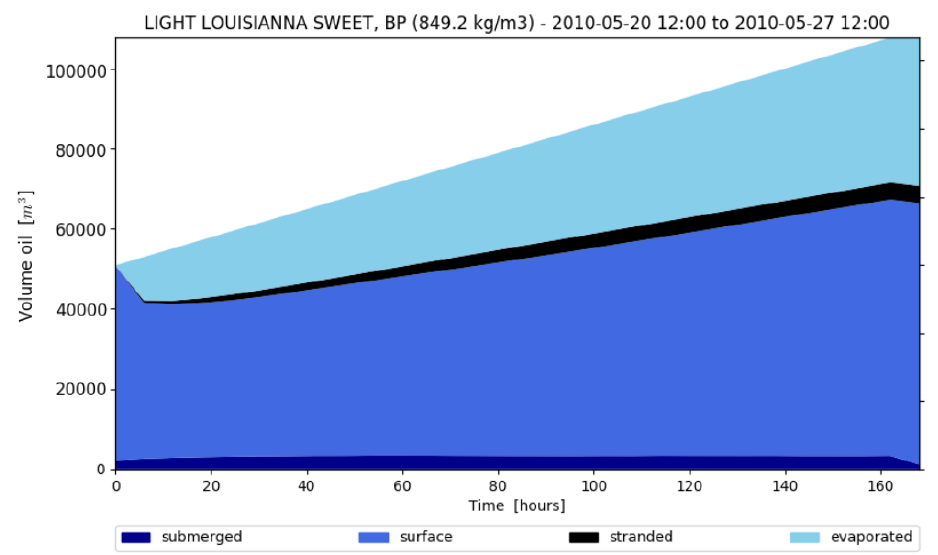
Figure 5. Mass balance of oil in the OpenOil simulation shown in Figure 2. The Li et al. [42] oil droplet size distribution is used.